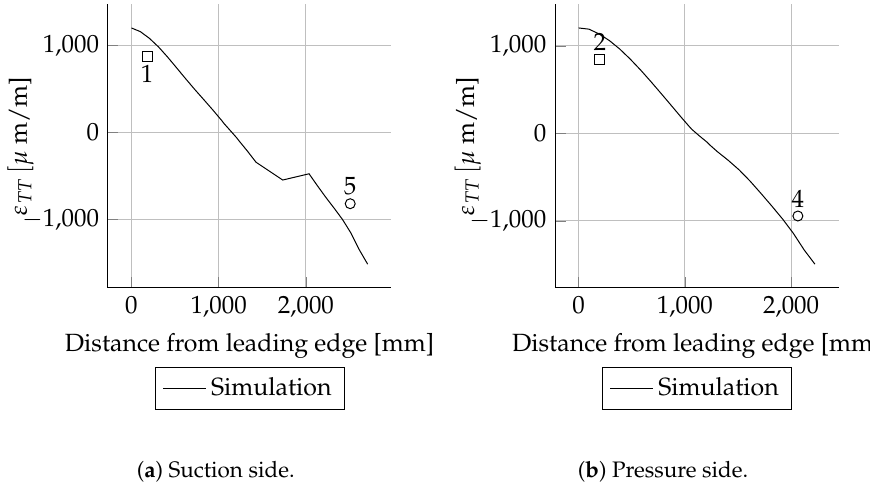
Figure A16. Strain comparison ε LL at radial position R = 1600 mm for Mxmin load case.